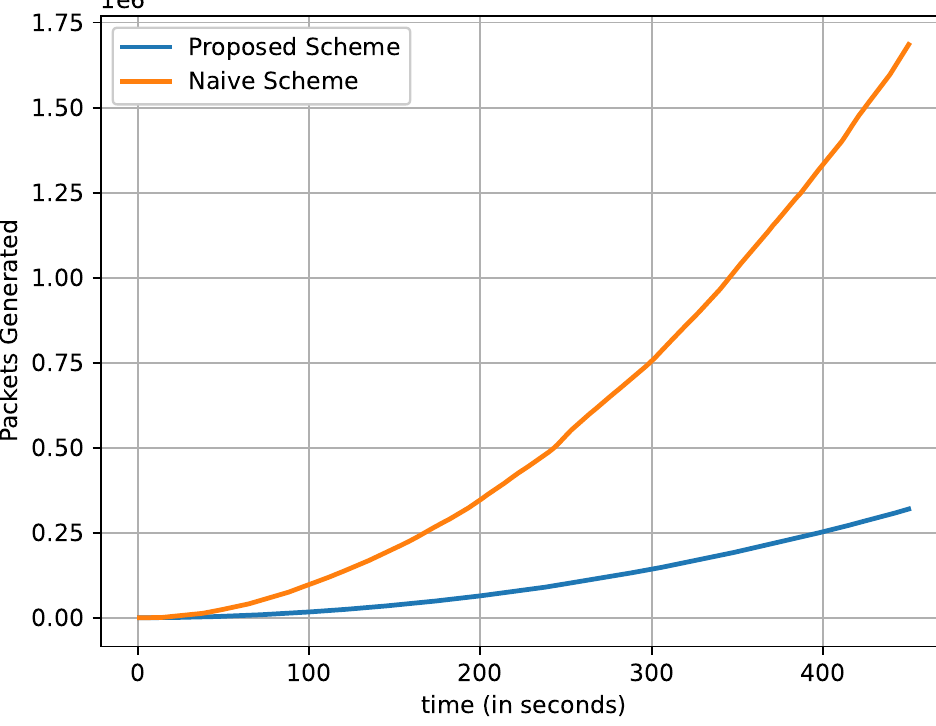
Figure 7. Total number of transmitted critical data packets with respect to the increasing number of vehicles (time in